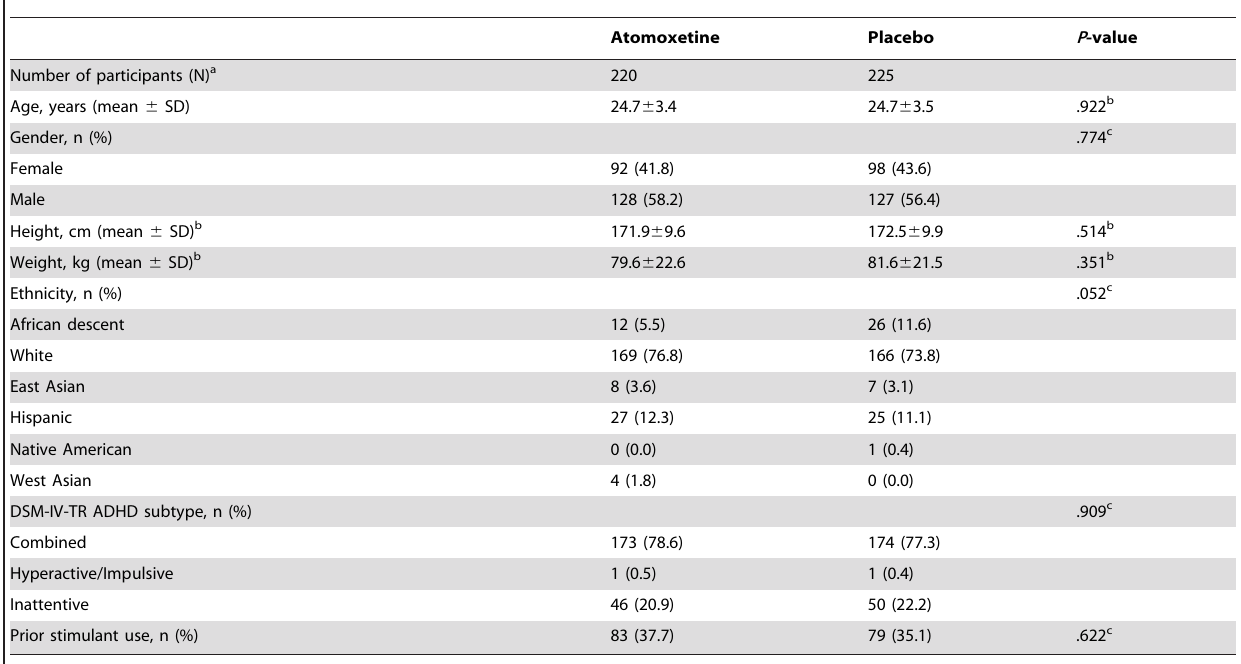
Table 1. Patient Baseline